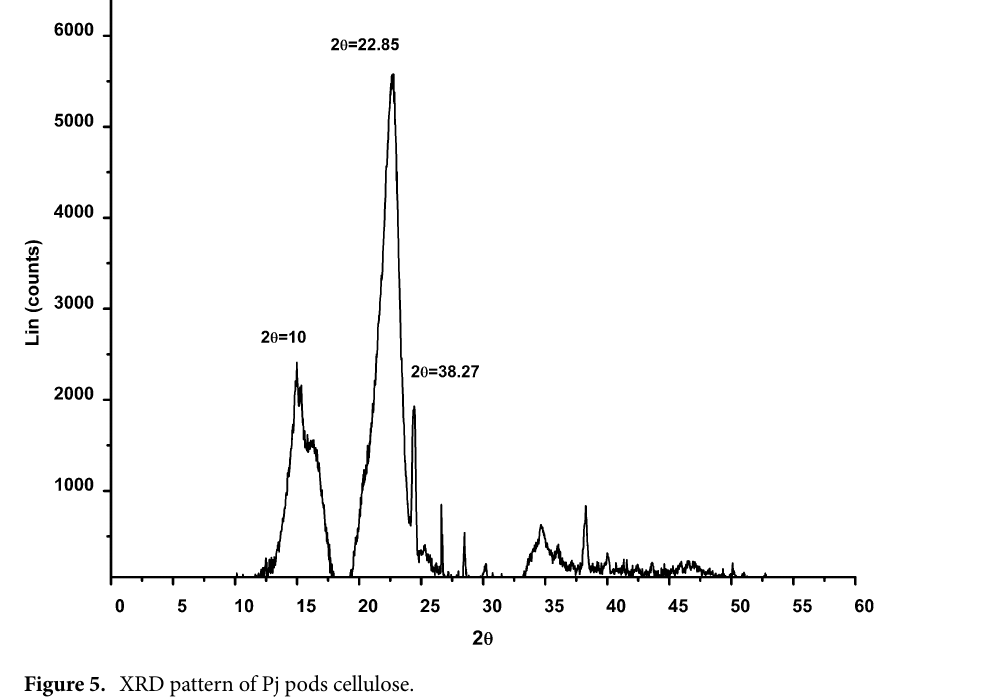
Figure 5. XRD pattern of Pj pods